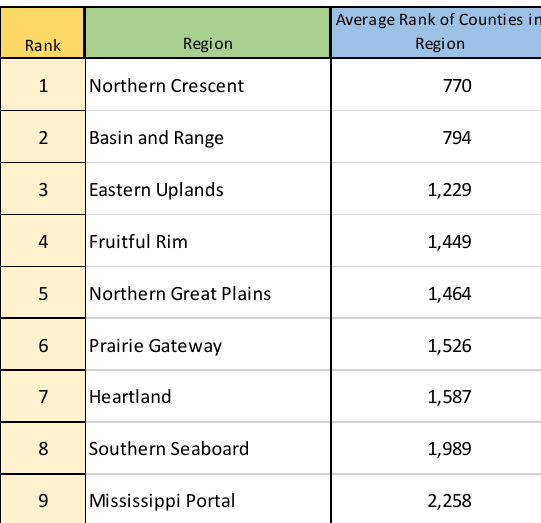
Table 4. Region Ranking, 2007 Table 5. Region Ranking,